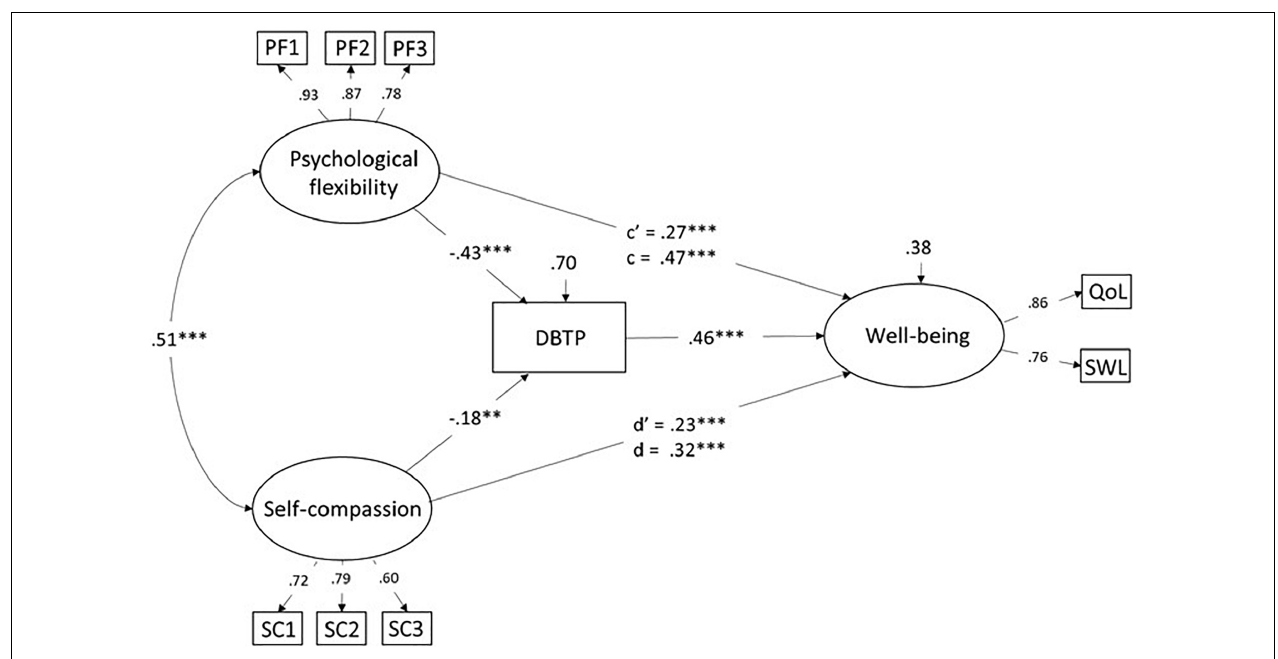
FIGURE 2 | Structural model involving DBTP as a mediator of the relationship between psychological flexibility, self-compassion, and well-being. Values are standardized coefficents. c’ = direct effect, c = total effect.